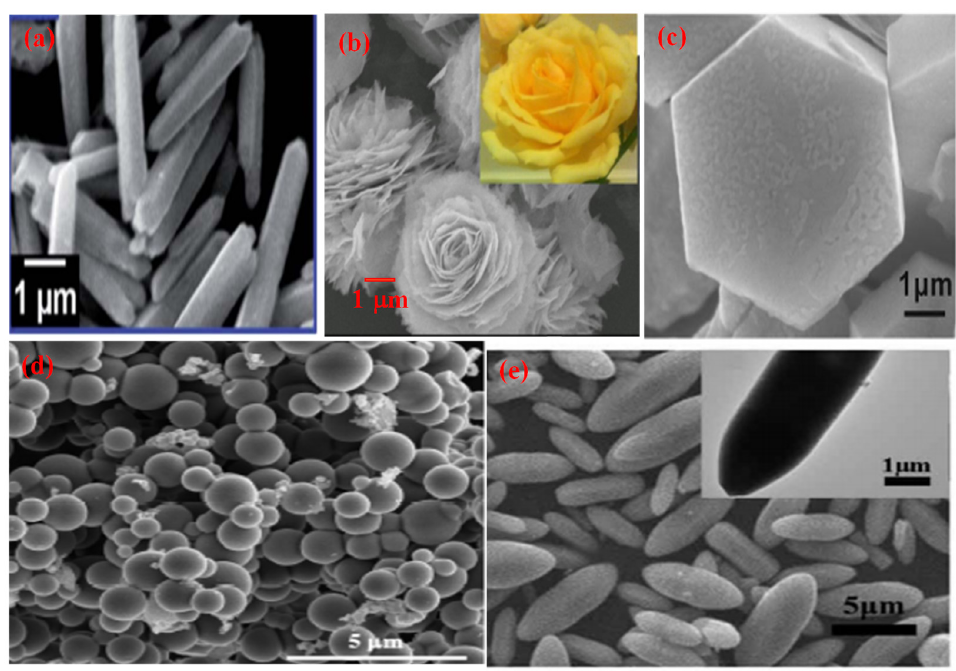
Figure 3. SEM micrographs of different morphologies of ZnO ( a ) Nanorod (Reprinted with permission from [63]. Copyright 2014 Royal Society of Chemistry), ( b ) Nanoflower (Reprinted with permission from [64]. Copyright 2016 Elsevier), ( c ) Hexagonal (Reprinted with permission from [65]. Copyright 2017 Royal Society of Chemistry), ( d ) Nanospheres (Reprinted with permission from [66]. Copyright 2019 Elsevier), ( e ) Nanospindles (Reprinted with permission from [67] Copyright 2017 Elsevier).